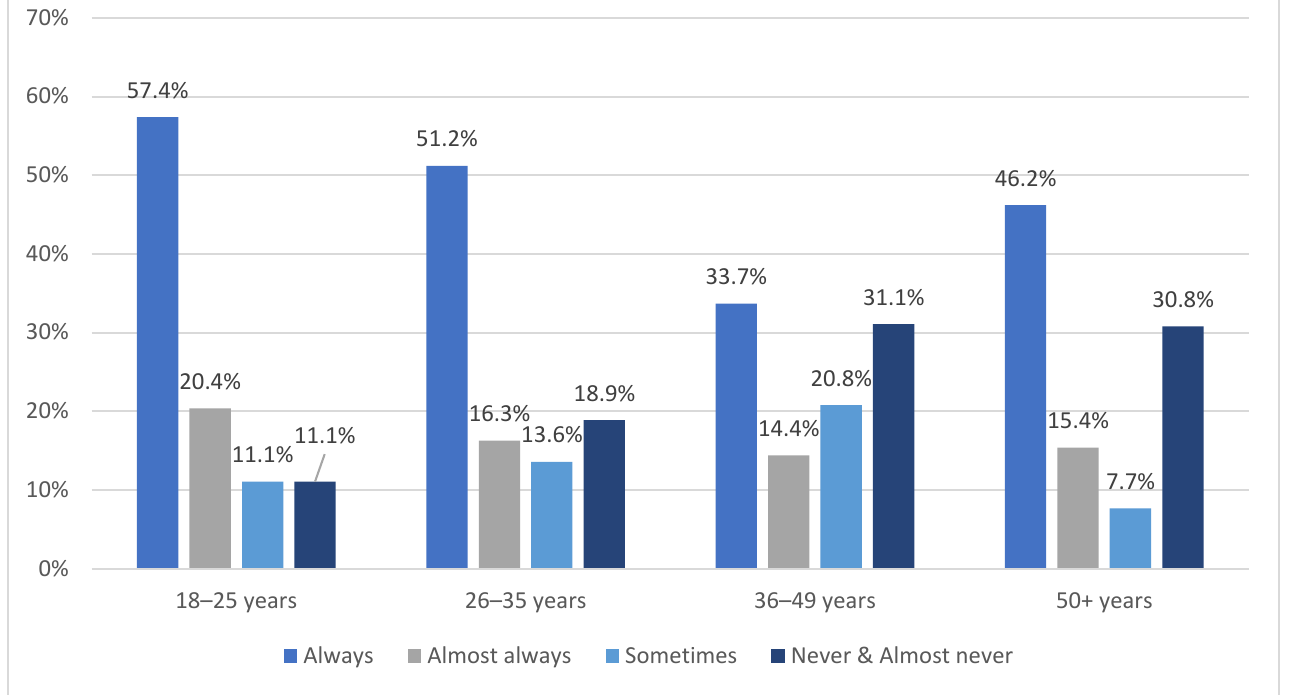
Figure 1. Respondents’ age group and frequency of restraint use for their eldest child while travelling in their vehicle.